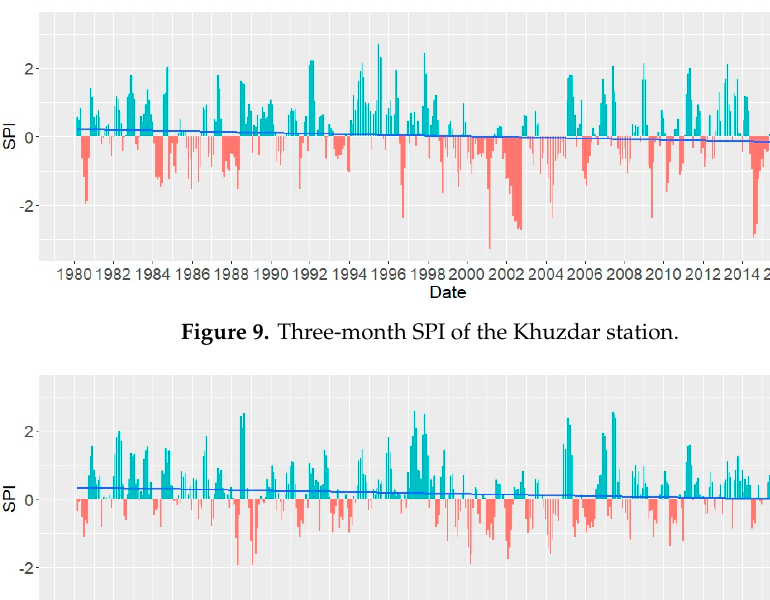
Figure 8. Three-month SPI of the Zhob station.